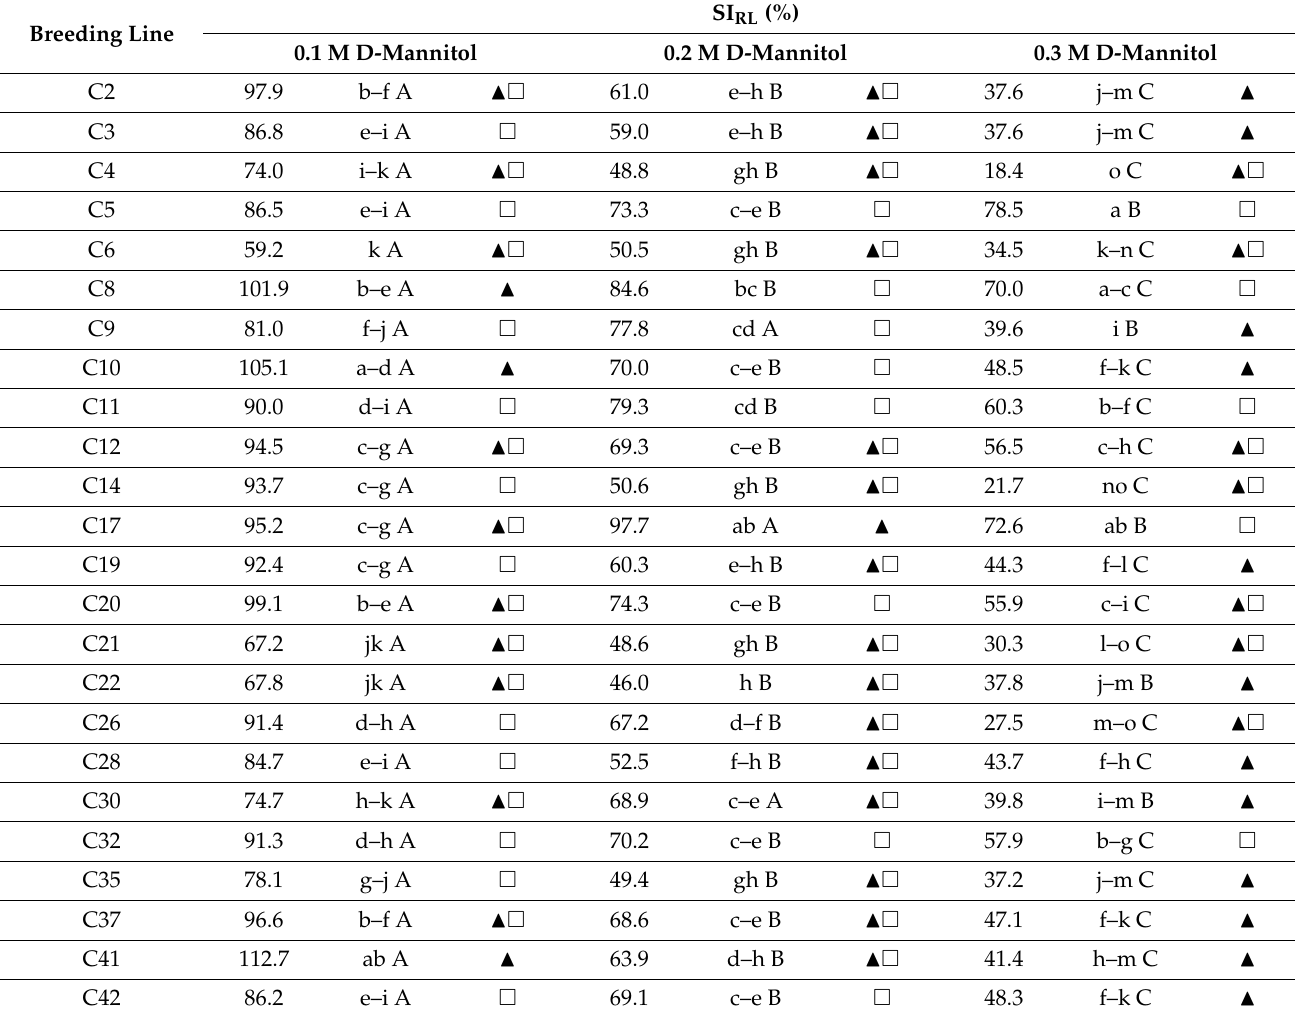
Table 12. Root length SI (SI RL ) values of potato genotypes under stress treatment induced by D- mannitol added to the medium at levels of 0.1 M, 0.2 M and 0.3